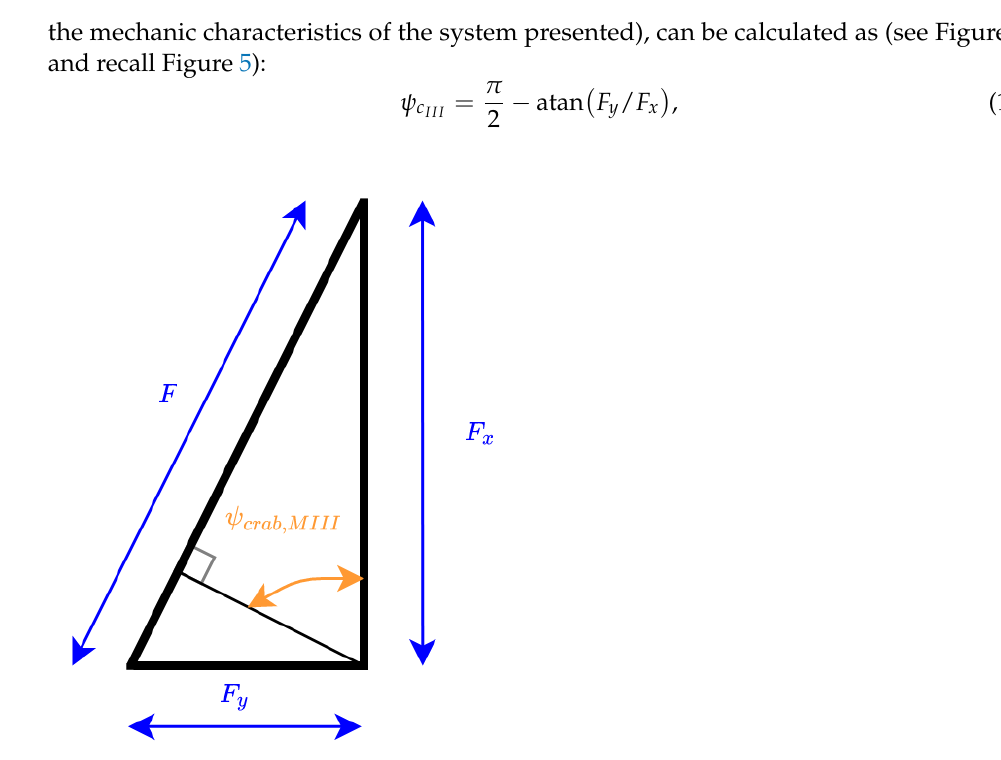
Figure 8. Maximum entrance Scenario III gap calculus